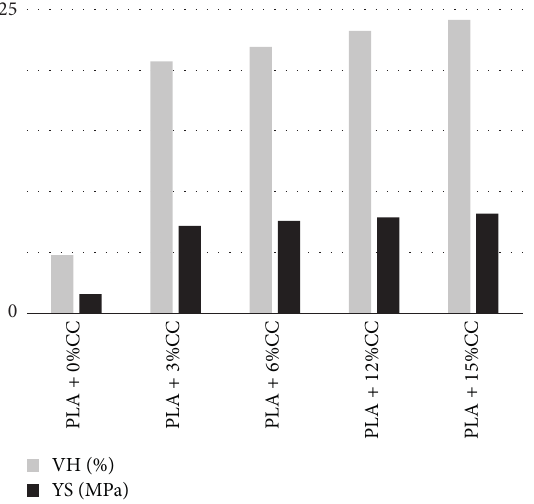
Figure 6: Variation of VH and YS at different cellulose